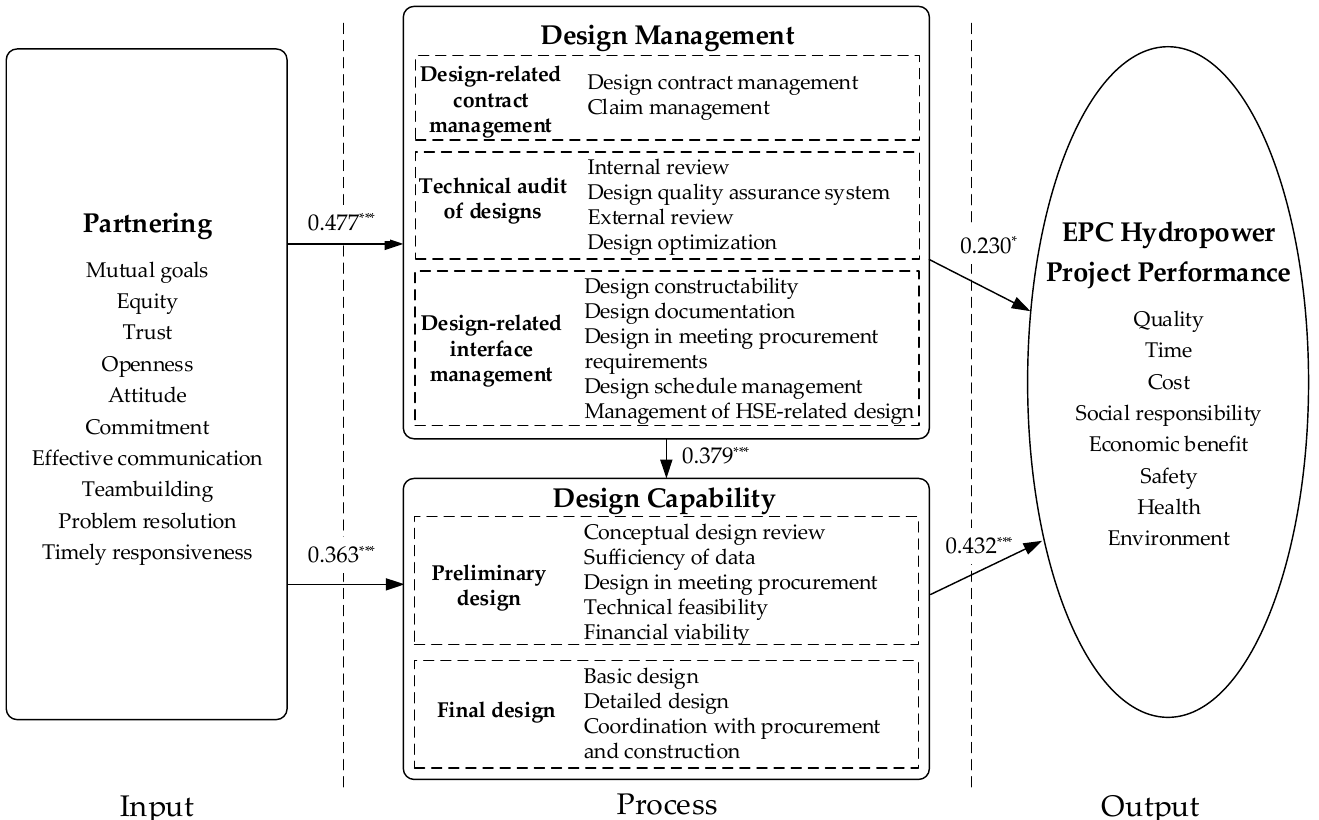
Figure 2. Relationships among partnering, design management, design capability, and hydropower project performance.